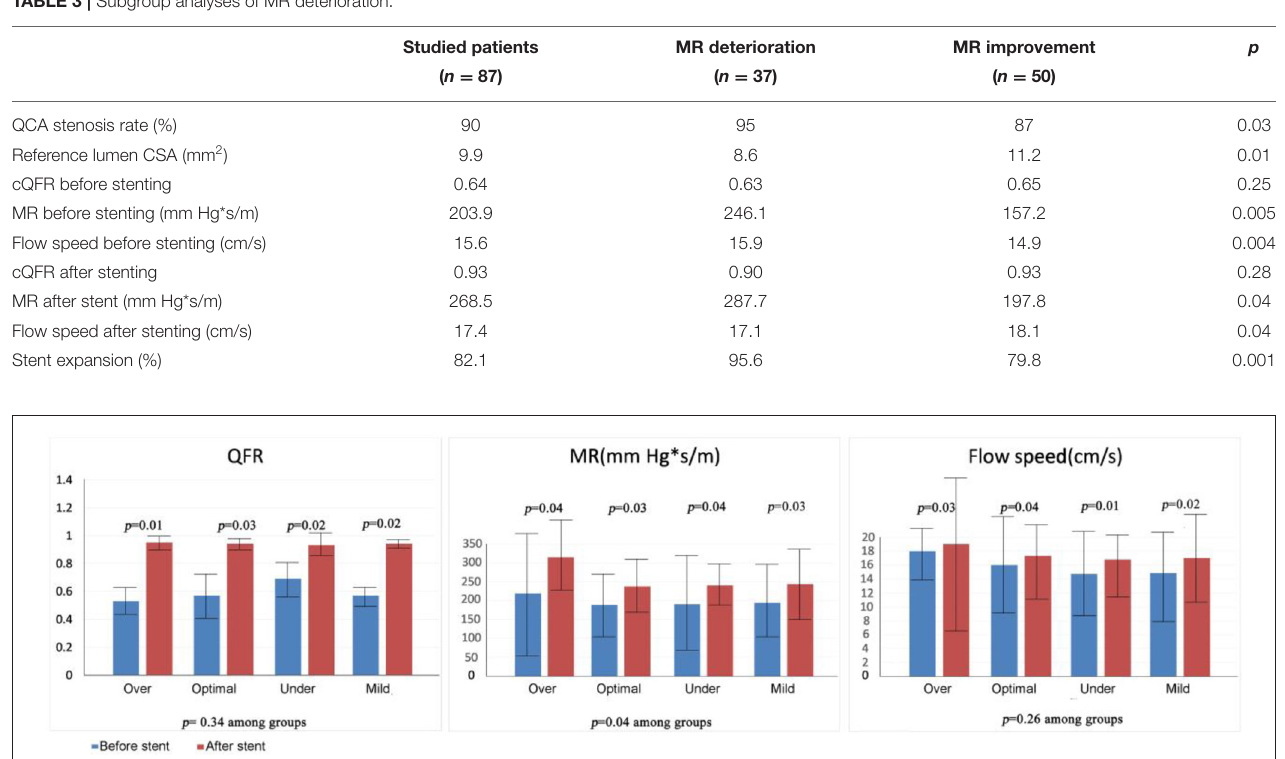
TABLE 3 | Subgroup analyses of MR deterioration.